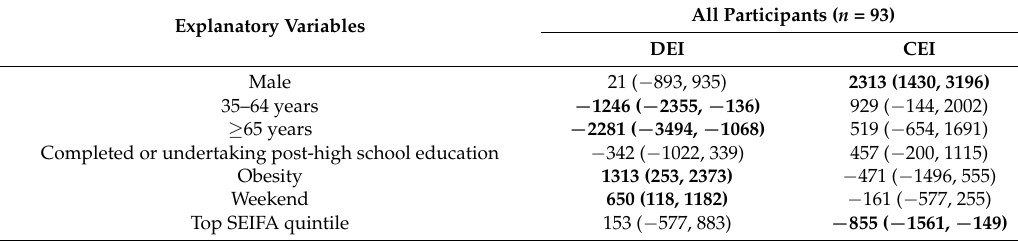
Table 1. CEI and DEI and associations with sociodemographic variables.